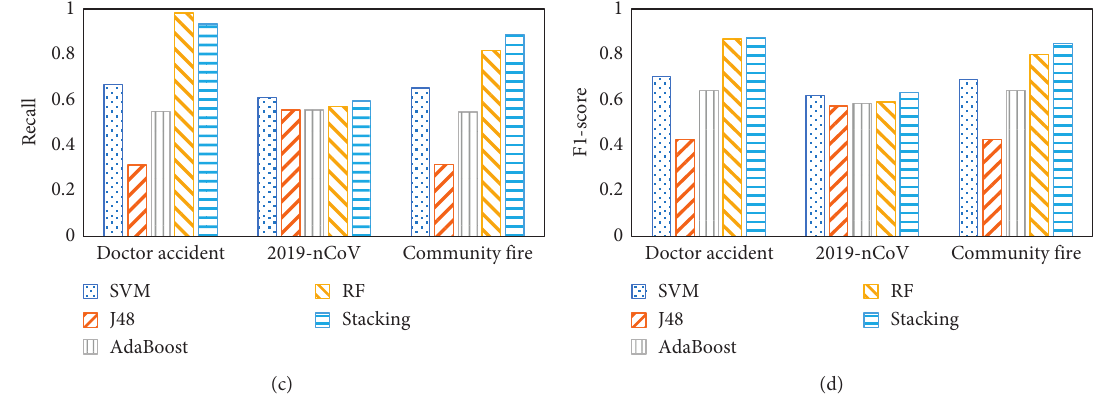
Figure 7: Empirical analysis results-Stacking.